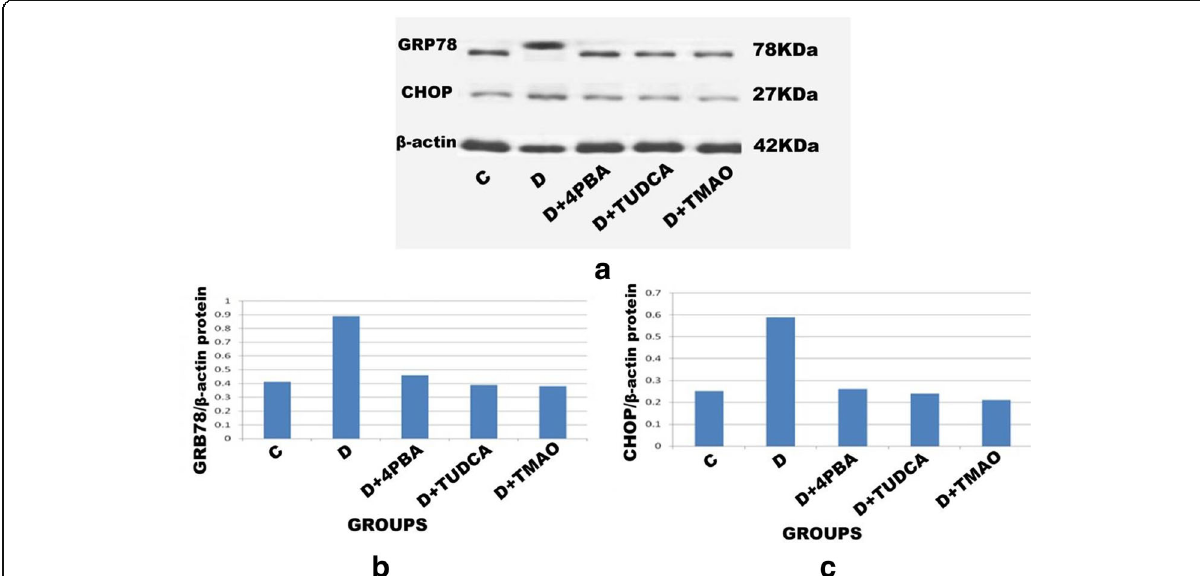
Fig. 6 Western blot analysis of ER stress-associated protein markers (GRP78 and CHOP) in lens homogenates of control and experimental groups. a Represents immunoblotting of GRP78 and CHOP. b , c The bar graph indicates the staining intensity of each band normalized to an internal marker B-actin